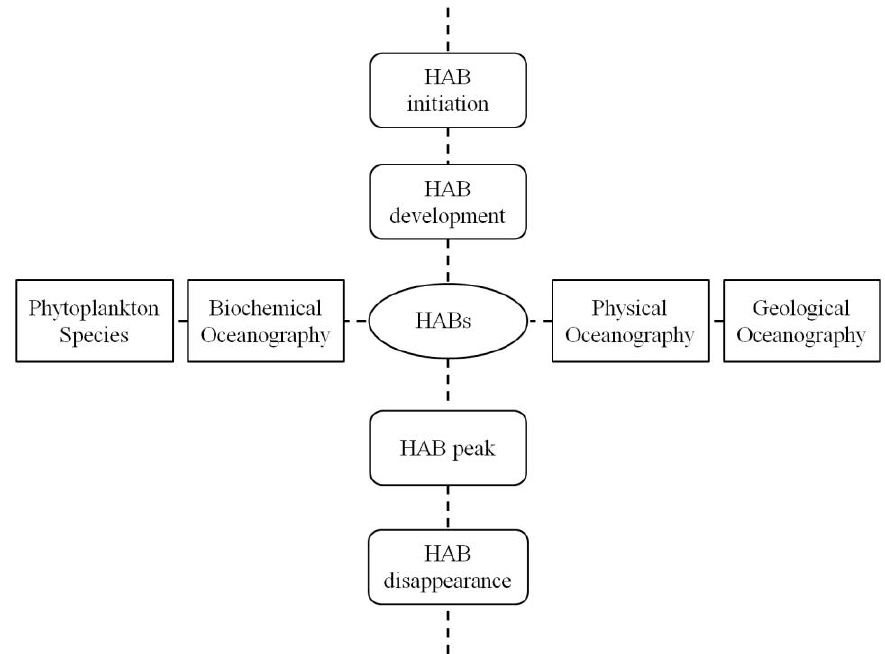
Figure 1. The cross pattern of HAB dynamic